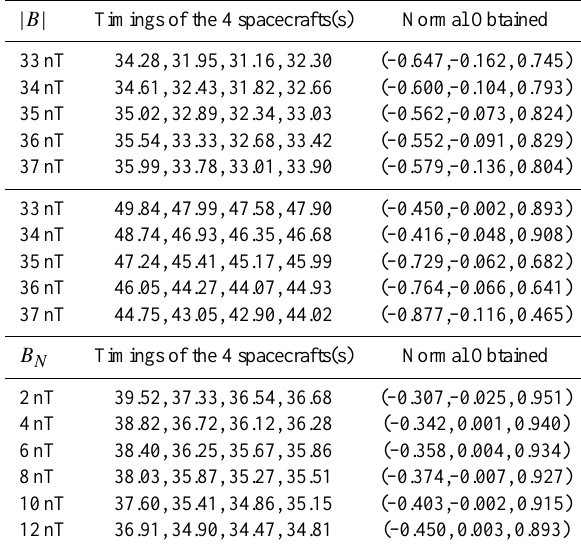
Table 1. The results of the Triangulation method as the first step of MTA: | B | or B N selected as the signals, timings input and the normals obtained.